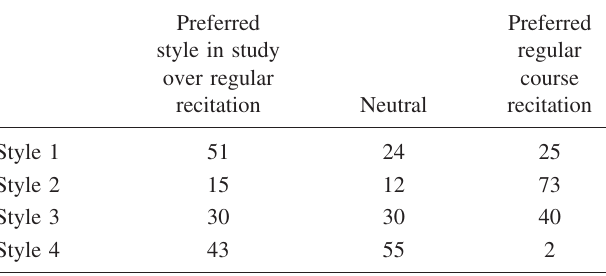
TABLE IX. Teaching style preference question